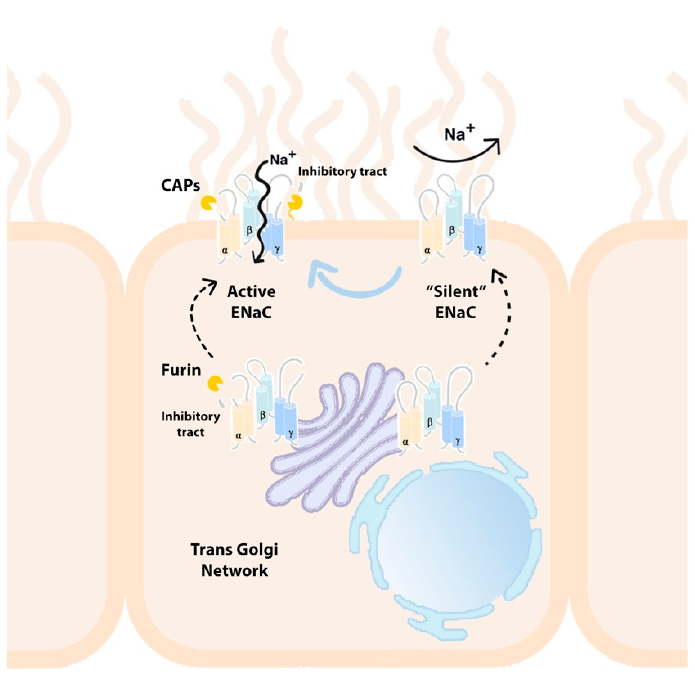
Figure 2. ENaC is a heterotrimeric structure composed of α , β and γ subunits at the apical surface of the airway epithelium. Newly synthesised ENaC is trafficked intracellularly through the trans-Golgi network (TGN) where it is subject to cleavage by furin at two specific sites in the α subunit, which results in the release of a peptide inhibitory tract. Partial cleavage of one site in the γ subunit by furin also takes place. The γ subunit requires further processing at the cell surface by channel activating proteases (CAPs), some of which are TLPs, at a site distal to the furin cleavage site in order to fully activate ENaC through the release of a second inhibitory fragment. Alternatively, a subpopulation of channels known as “silent” ENaC are able to bypass furin processing in the TGN and move directly to the cell membrane where they show minimal activity until they are cleaved by soluble or membrane-bound CAPs.